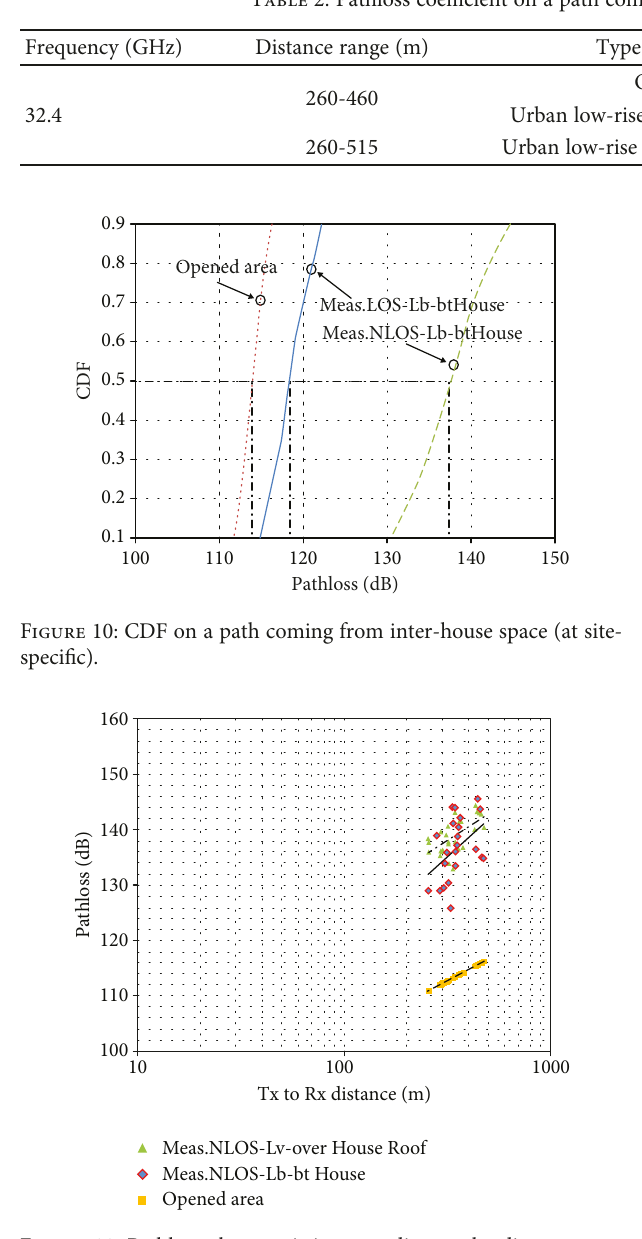
Figure 11: Pathloss characteristics according to the distance on a route that passes over the house roof (at site-speci fi c).